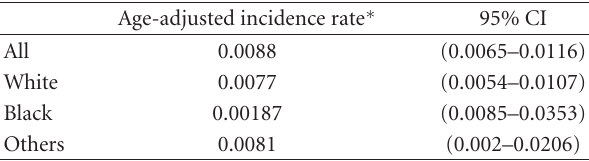
Table 1: Age-Adjusted Incidence Rate of Signet Ring Prostate